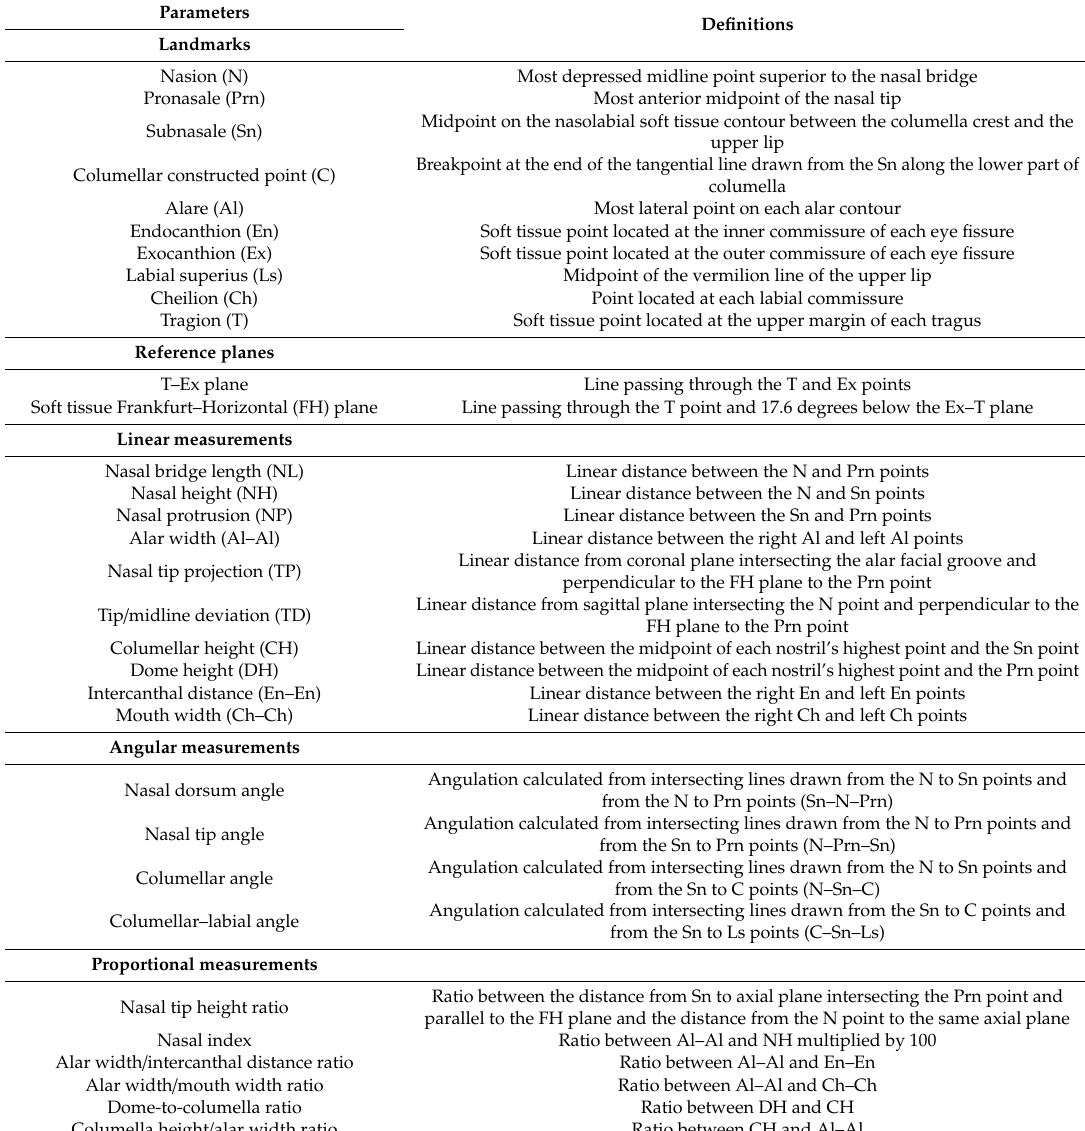
Table 1. Parameters adopted for three-dimensional nasal photogrammetric